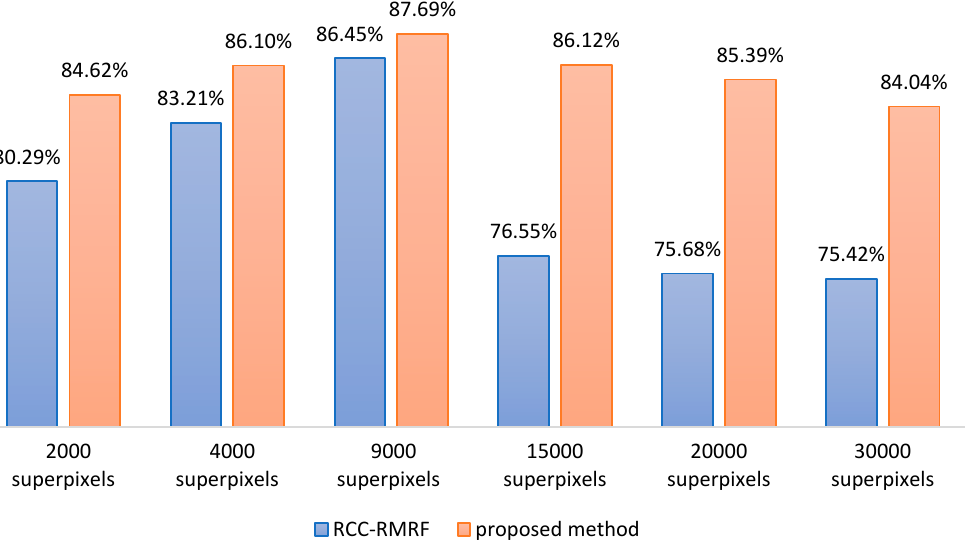
Figure 9. The classification results of RCC-MRF and the proposed method on the SF-Bay image.